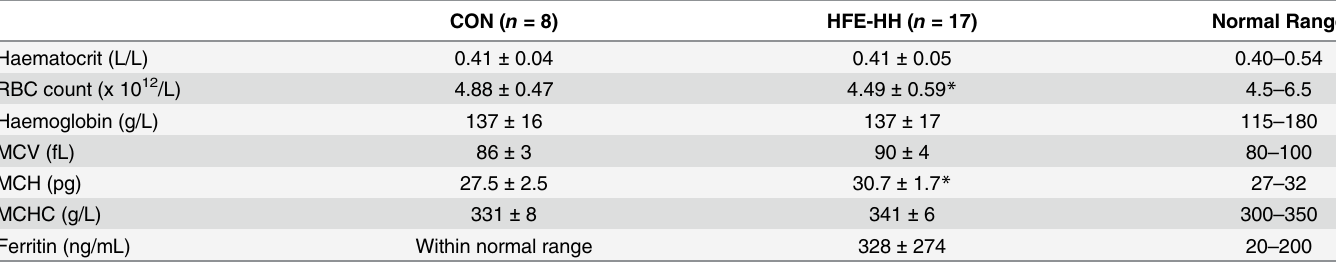
Table 1. Venous blood characteristics of HFE-HH and control